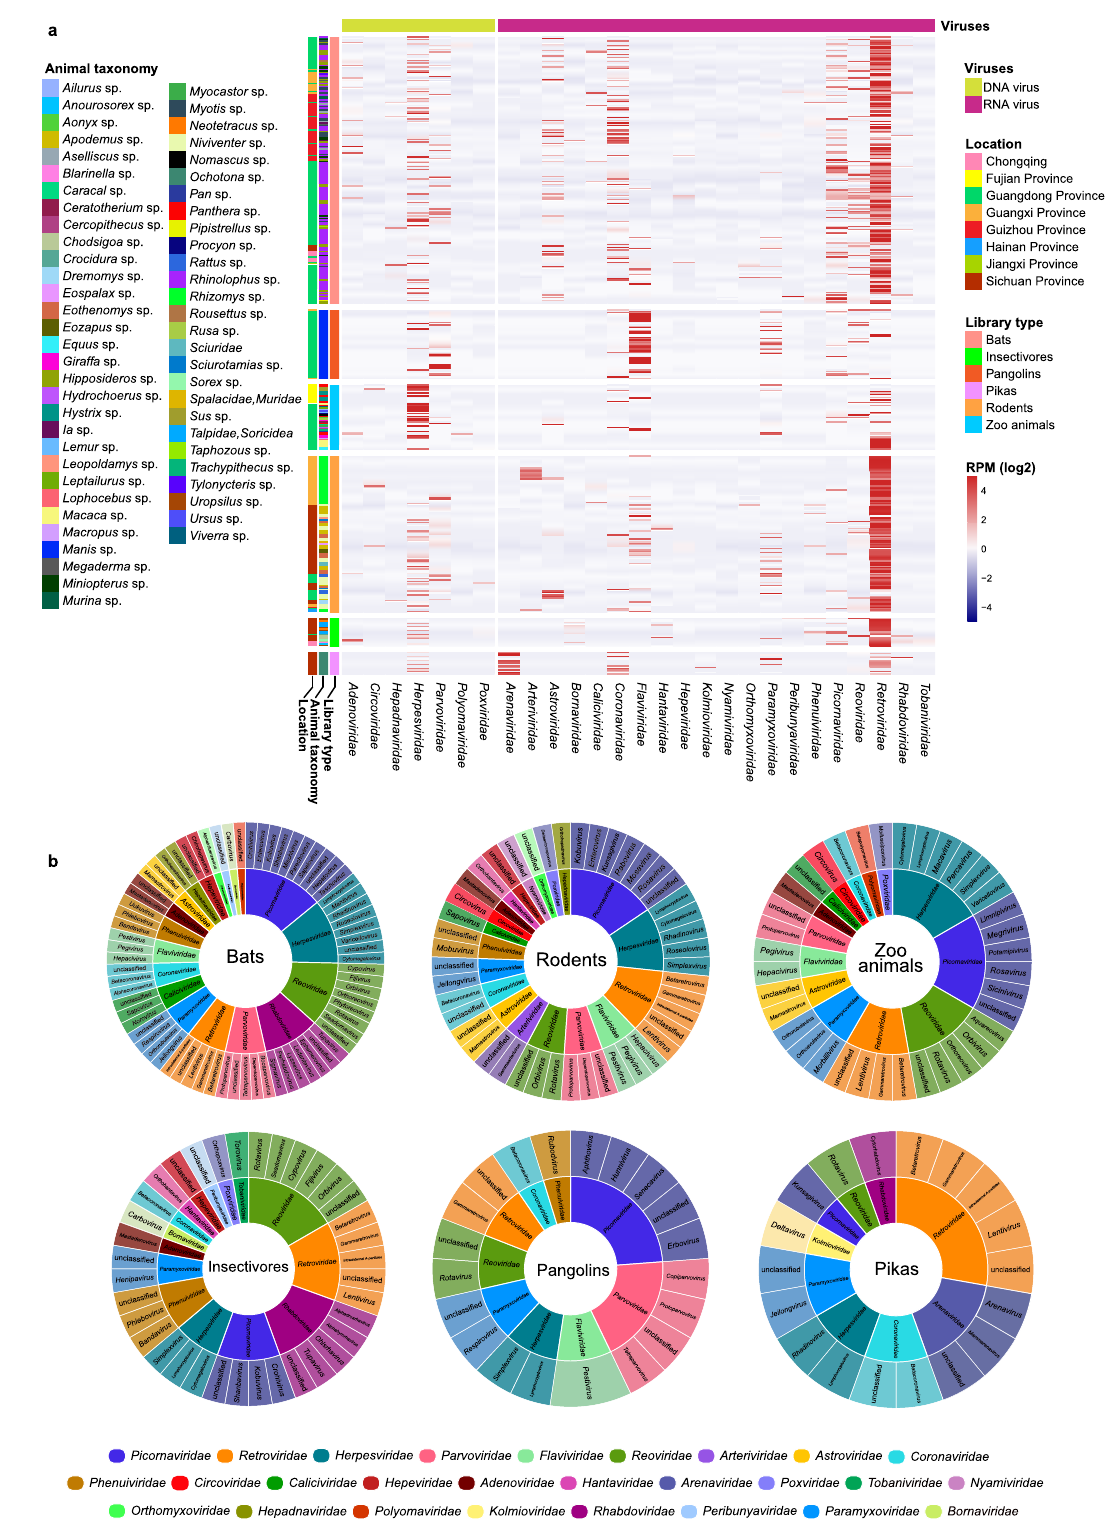
Fig. 1 | Overall view of the viral reads in the meta-transcriptomic data. a Heatmap based on normalized sequence reads of 27 families of mammalian viruses in each pooled sample and their Chinese province of sampling. Names of mammalianviralfamiliesarepresentedinthetextrowatthebottom. b Overviewof